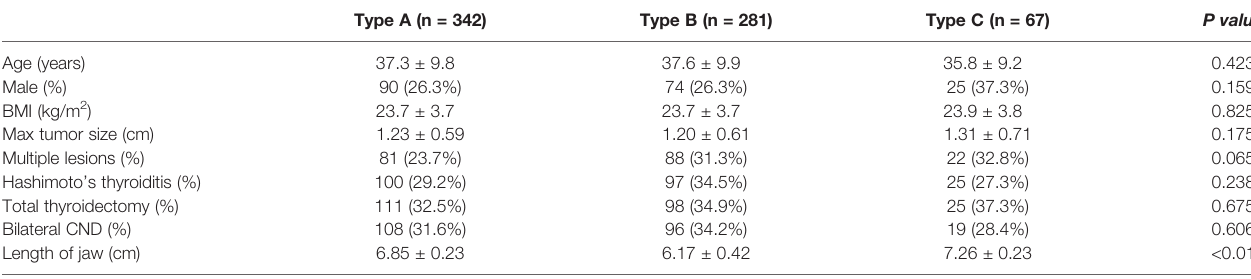
TABLE 1 | Comparation of clinicopathological characteristics in the groups of type A, B, and